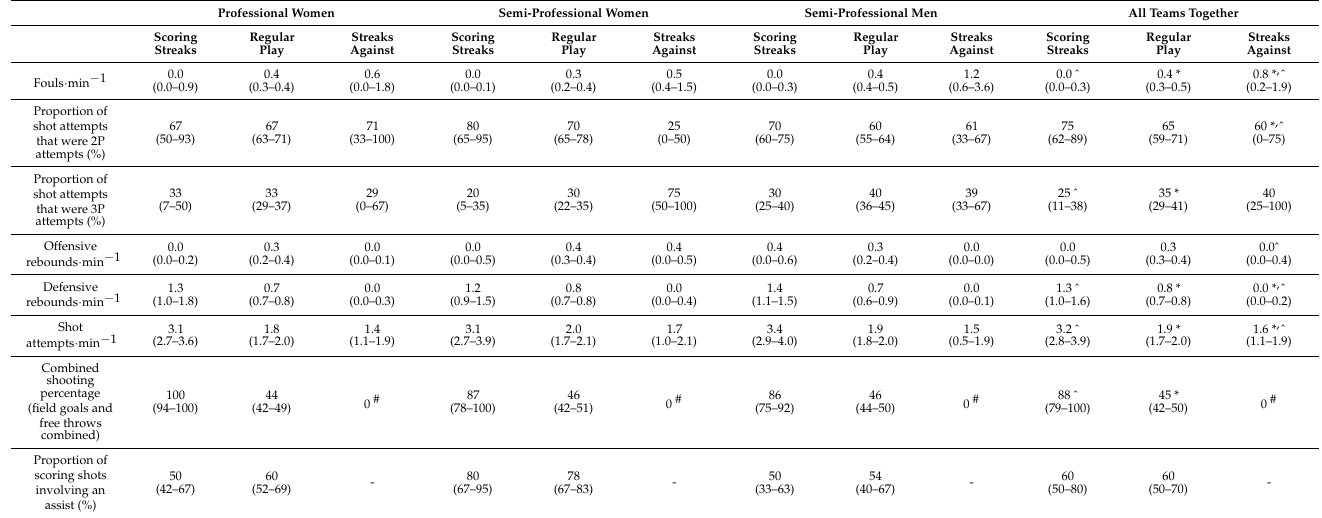
Table 3. Game-related statistics during scoring streaks, streaks against and regular play for each team and for all